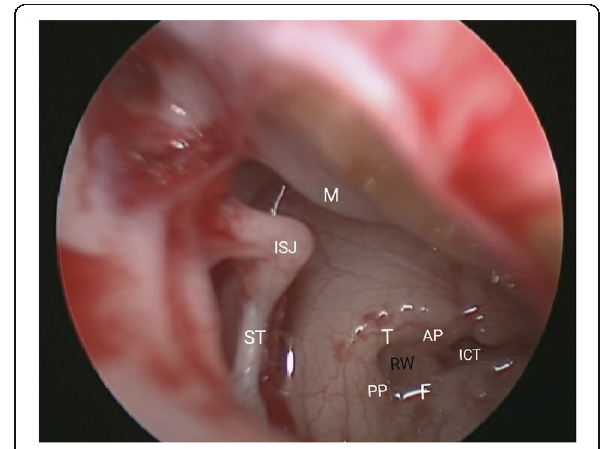
Fig. 2 Endoscopic view of the right ear showing the detailed ME anatomy and RW niche. AP (anterior pillar), PP (posterior pillar), F (fustis), T (tegmen), RW (round window), ICT (infracochlear tract), M (malleolus), ISJ (incudo-stapedial joint), and ST (stapedius